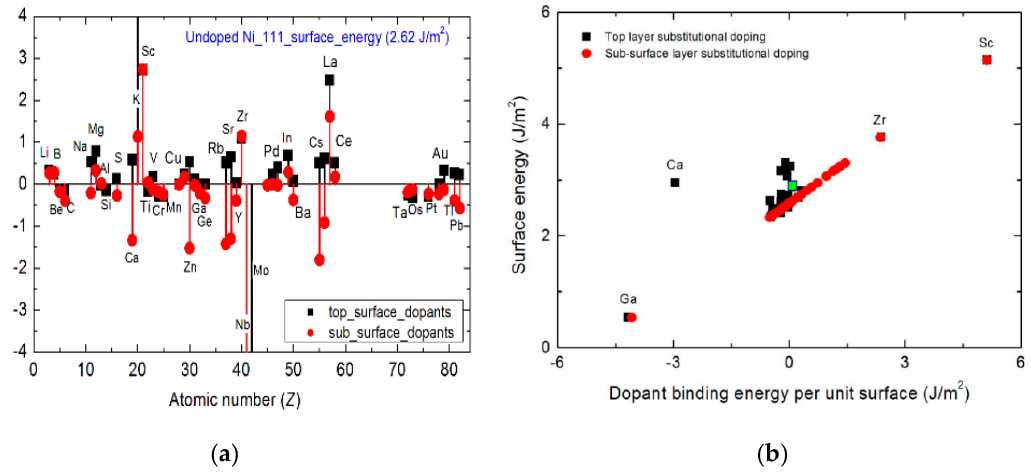
Figure 4. Effects of single-atom dopants on the free energy of the Ni(111) surface for top-surface (black squares) and sub-surface (red spheres) doping ( a ). Correlation between the surface energy and the dopant binding energy per unit area in the absence of the carbon adsorbate ( b ). The changes in the surface energy with doping are determined relative to the free energy undoped surface, as indicated by the green square.